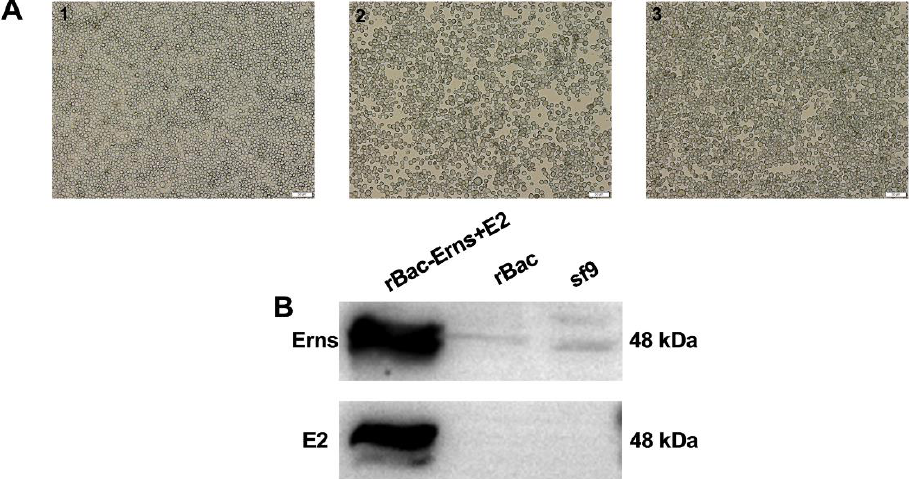
Figure 1. Expression of E rns and E2 proteins in Sf9 Cells. ( A ) Sf9 cells mock-infected or infected with rescued recombinant viruses are shown in the following order: (1) mock-infected Sf9 cells, (2) Sf9 cells infected with rBac-E rns +E2 (multiplicity of infection (MOI) = 0.1), (3) Sf9 cells infected with Bac only. ( B ) Western blot analysis of E rns and E2 expression in Sf9 cells. Cell lysates from Sf9 cells infected with rBac-E rns +E2 were subjected to Western blot analyses and E rns and E2 were detected by E rns pAb and E2 mAb 348, respectively. Cell lysates from Sf9 cells uninfected or infected with Bac vector were loaded as controls; numbers on the right indicate protein molecular weight in kDa.